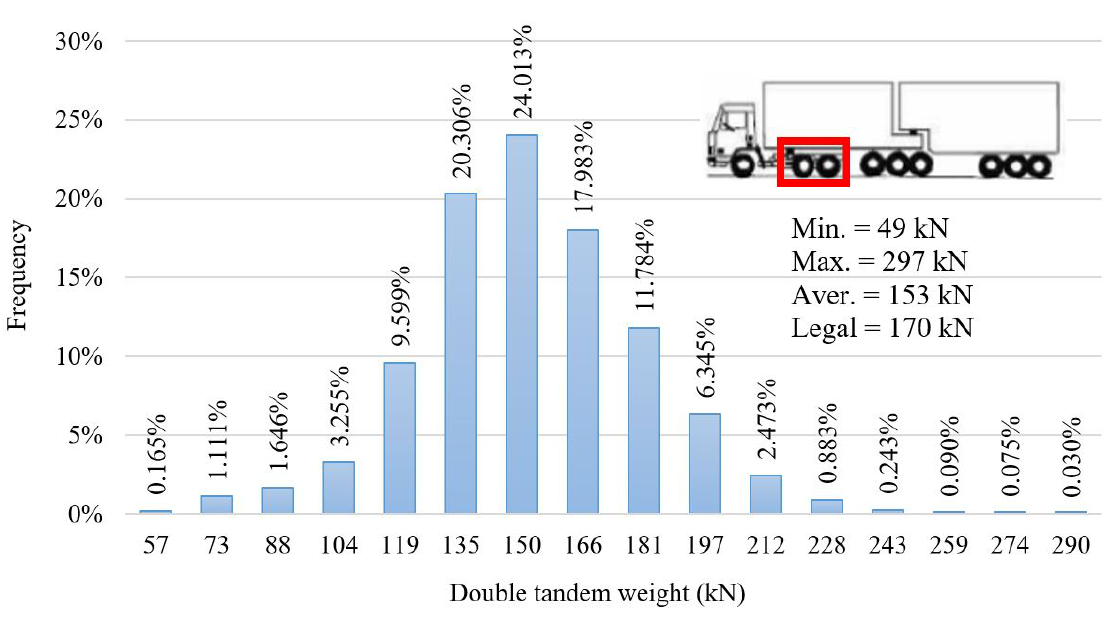
Figure 6. Histogram for weight for double tandem for class 3M6 (the horizontal axis shows the average values for each interval).